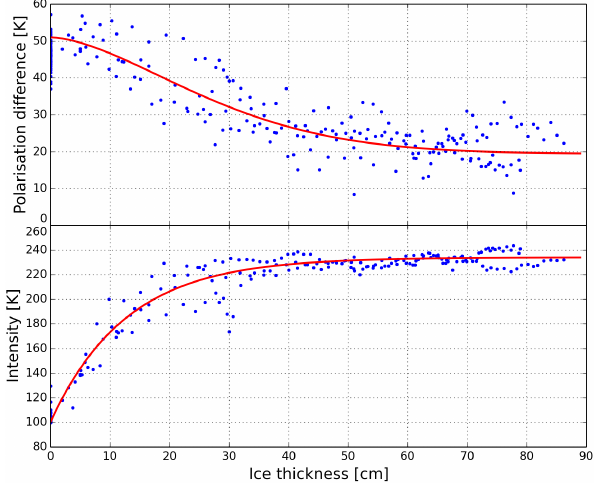
Fig. 5. Dependence of polarisation difference (top) and inten- sity (bottom) to ice thicknesses obtained from CFDD from NCEP/NCAR surface air temperature data. Red line shows a fit of an empirical function of polarisation difference and intensity to ice thickness.